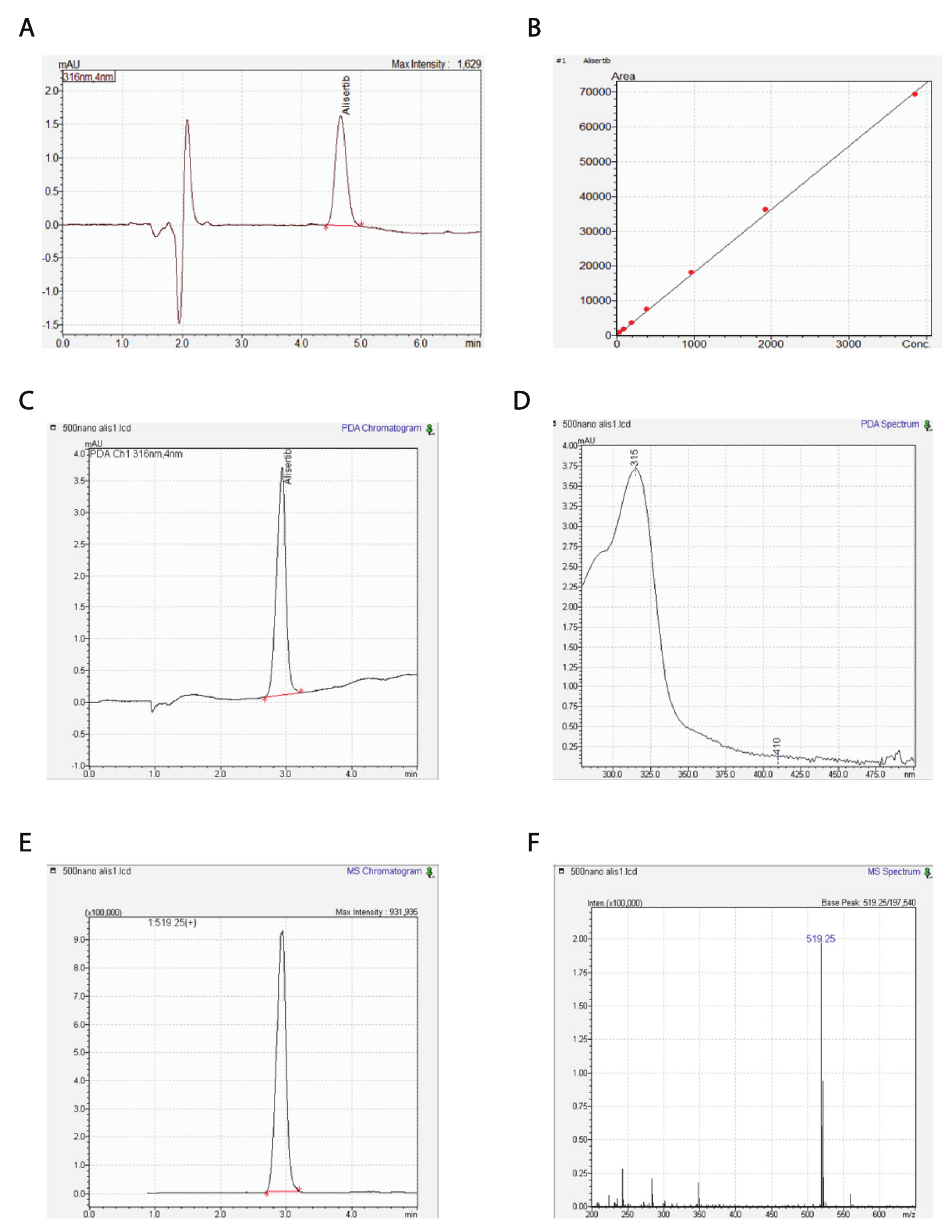
Fig 1. Alisertib can be detected by HPLC and LC-MS analysis. (a) DAD chromatogram of Alisertib standard injection for the developed HPLC method showing elution at 4.65 minutes (b) HPLC calibration curve for Alisertib from known concentrations (3854.2 nM, 963.54 nM, 385.43 nM, 192.71 nM, 96.35 nM and 38.54 nM) with an R 2 value of 0.9999. Limit of Quantification (LOQ) = 21.37 nM, and Limit of Detection (LOD) = 7.05 nM. (c) DAD chromatogram of Alisertib standard injected for LCMS analysis at 316nm showing elution at 2.94 minutes (d) DAD spectrum of Alisertib standard injected for LCMS analysis at 2.94 minutes. (e) Electron ion chromatogram of the 519.25 m/z [M+H] + for the Alisertib standard in acetonitrile showing elution at 2.94 minutes (f) Mass spectra of the 2.94 Alisertib minute peak showing the 519.25 m/z [M+H] + ion in highest abundance. The chromatogram shows one large prominent peak eluting at 2.94